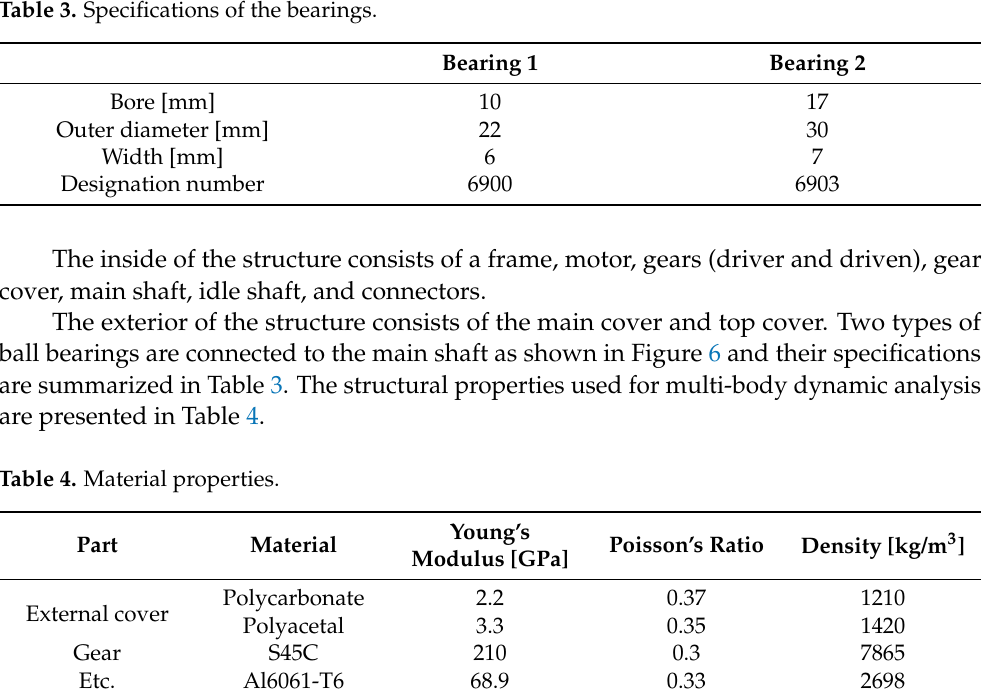
Table 3. Specifications of the bearings.